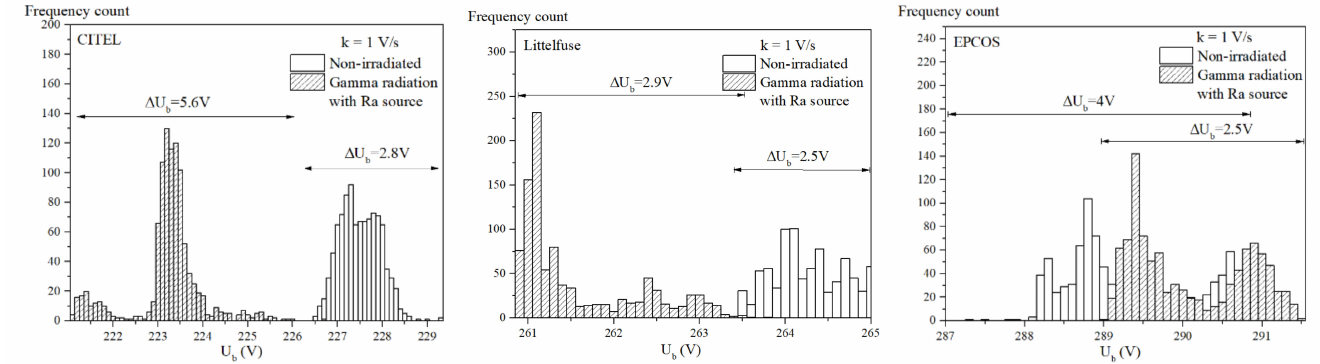
Figure 6. Frequency count of dynamic breakdown voltage of CITEL, Littelfuse and EPCOS GFSA for increase voltage rate k = 1 V/s for non-irradiated arresters and ones in the presence of gamma